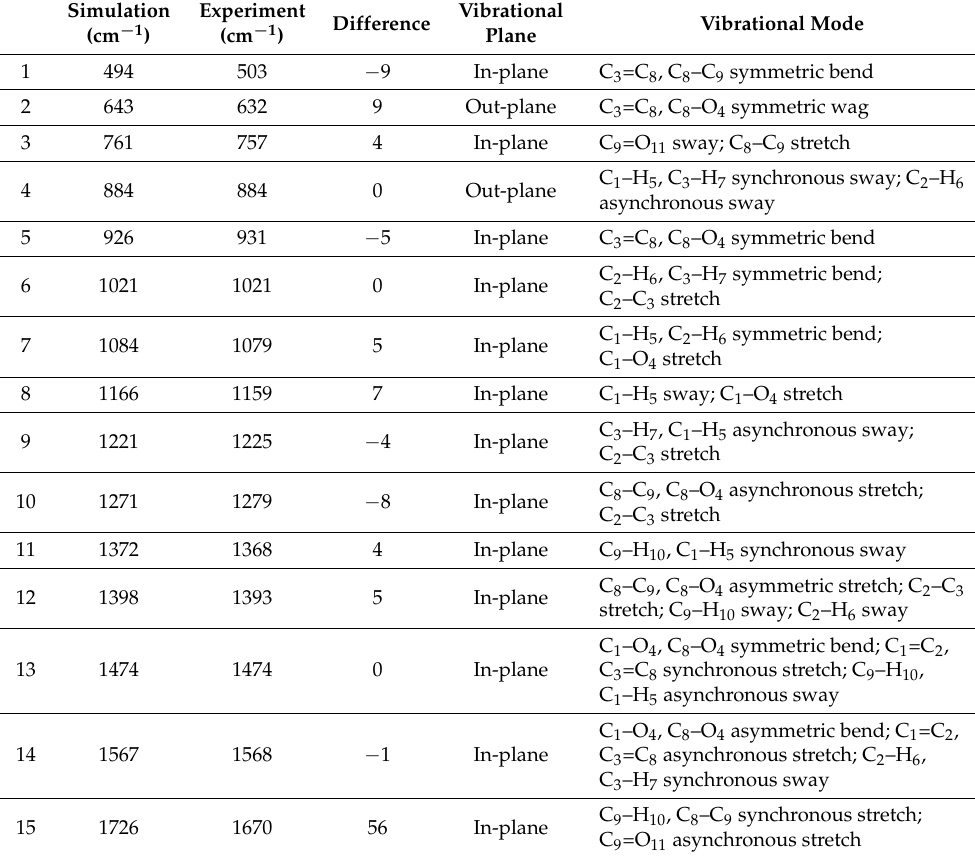
Figure 2. ( a ) Charge difference densities of furfural (the green and red stand for holes and electrons, respectively); ( b ) The static potential distribution of furfural (the red and blue represent low potential and high potential, respectively). Table 1. Raman vibration mode assignments of furfural molecules.